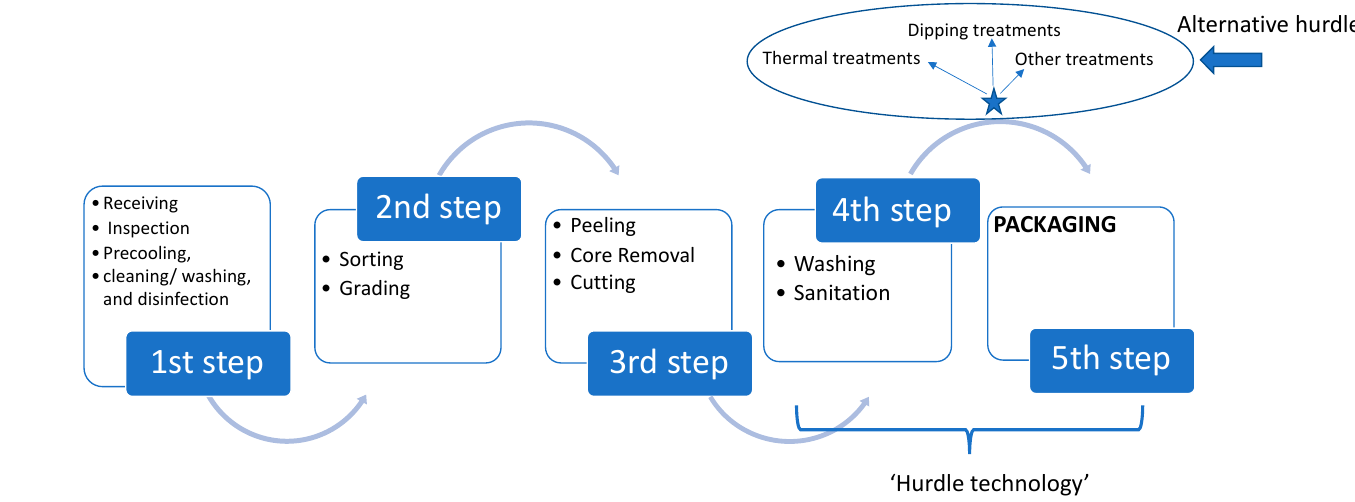
Figure 1. Indicative flow chart of fresh-cut fruits and vegetables’ manufacturing process.